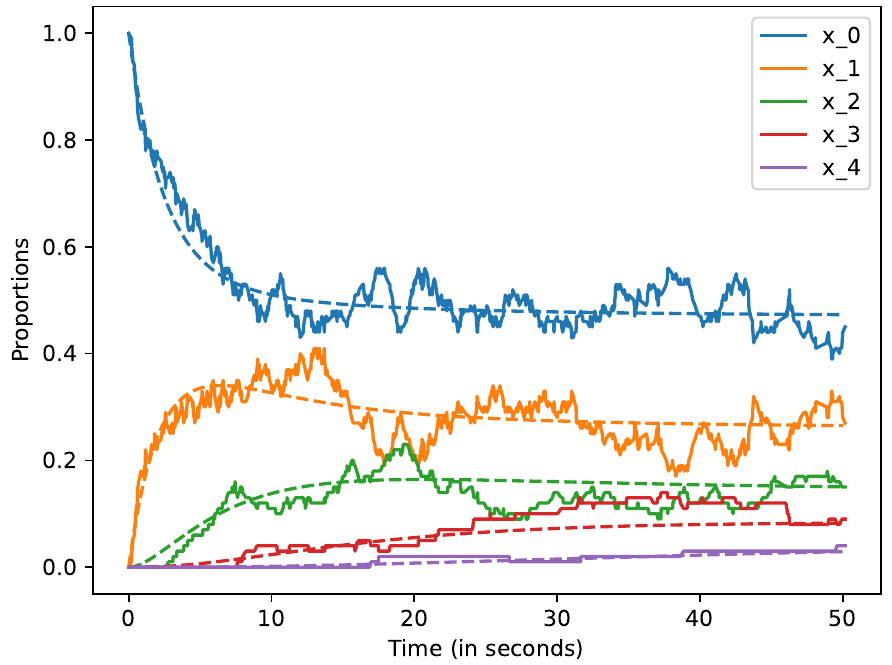
Figure 5. Mean-field approximation for N = 100 devices. Time in